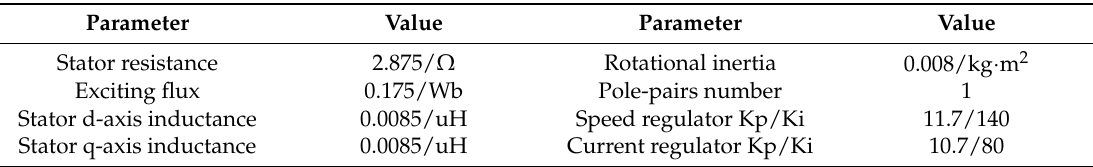
Table 2. Simulation parameters of